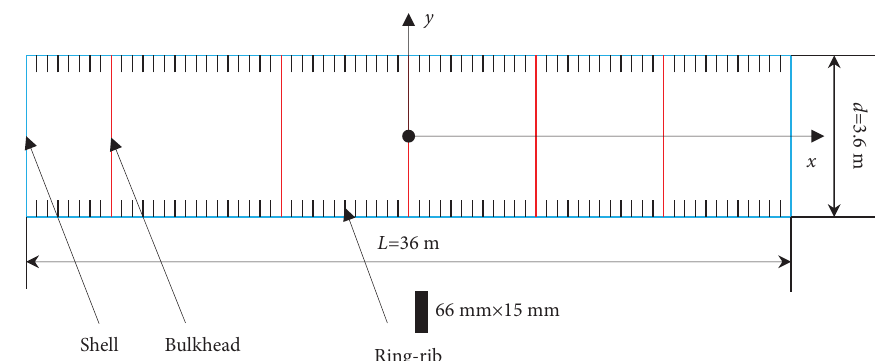
Figure 9: Te geometry of the cylinder.